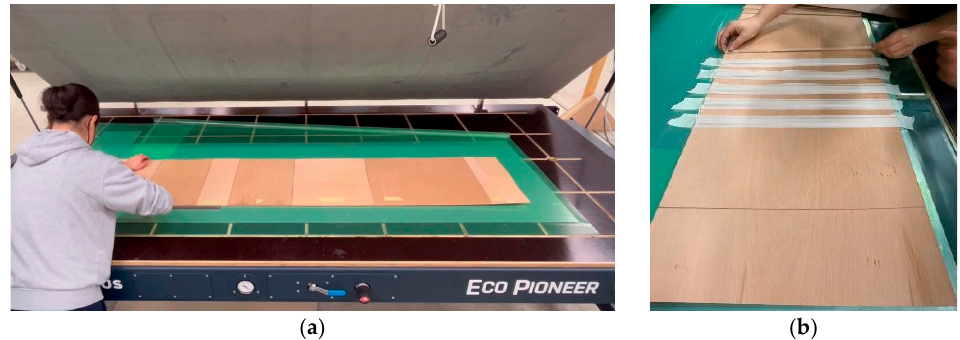
Figure 16. Vacuum table lamination of timber elements: ( a ) preparing timber surface lamination; ( b ) preparing additive groove lamination.